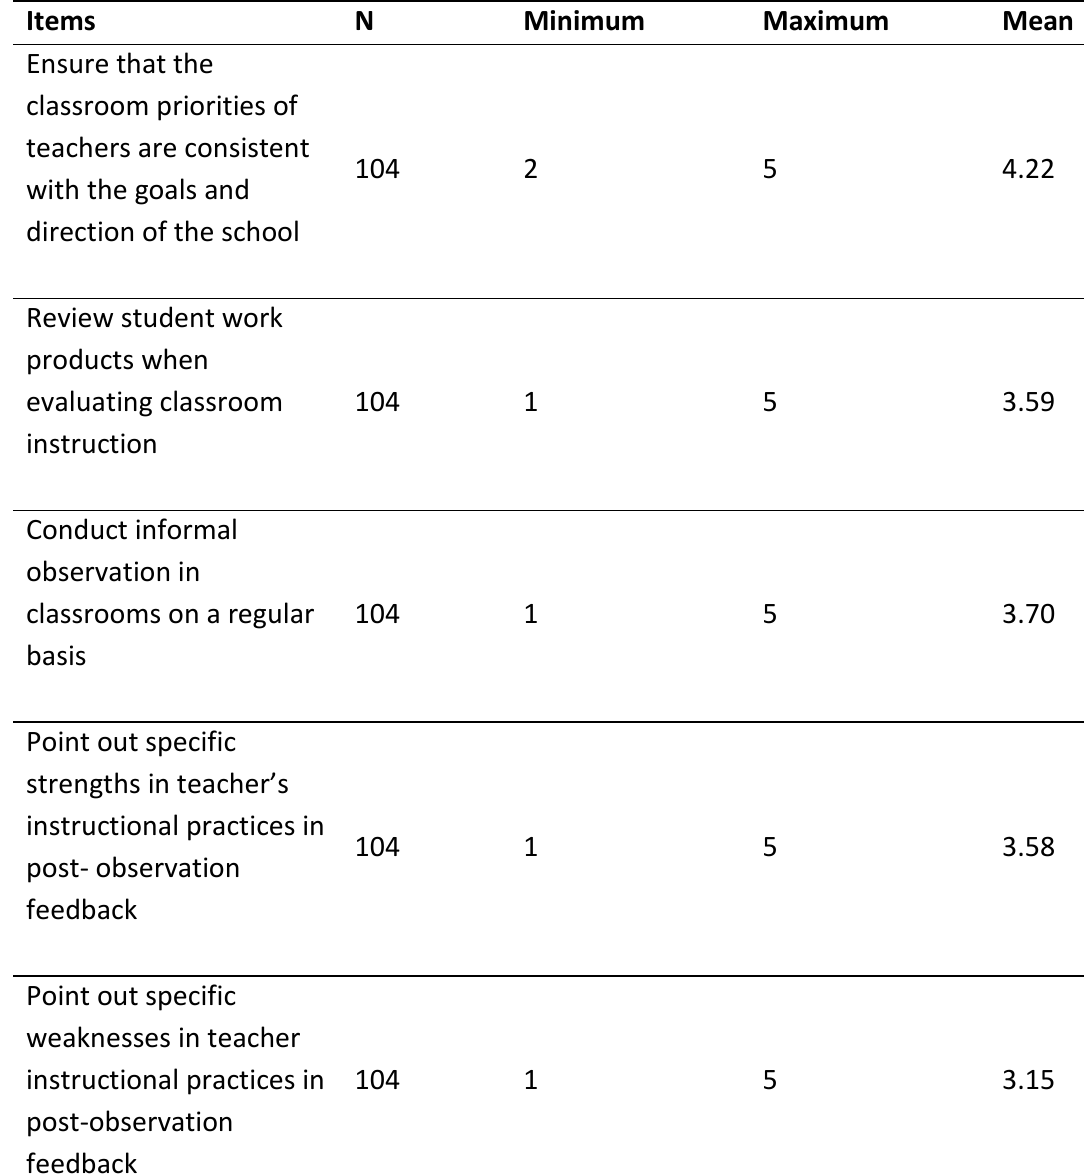
Table 2: Mean Scores of Supervise & Evaluate Instruction Items Ensure that the classroom priorities of teachers are consistent with the goals and direction of the